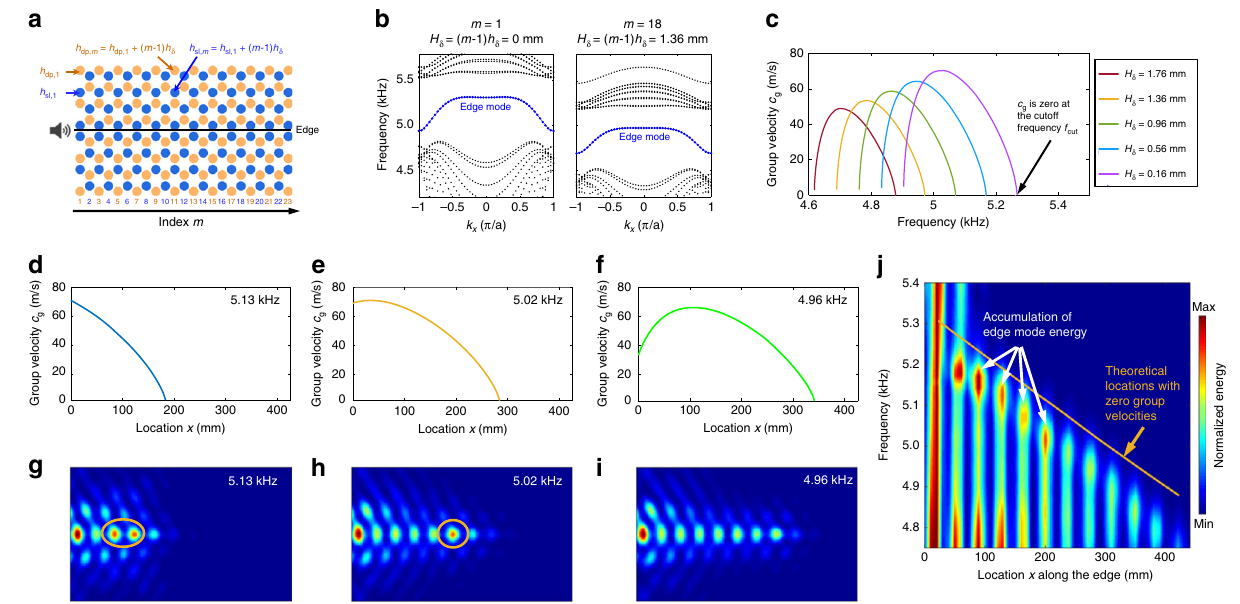
Fig. 5 Demonstrations of rainbow edge waves in chirped valley phononic crystals. a Con fi guration of chirped valley phononic crystals (PCs) for transporting edge modes of surface acoustic waves (SAWs) along a straight interface. The blue and brown circles in the m th column represent shallow and deep cavities with depths of h sl ,m and h dp ,m . The cavity depths gradually increase with the increase of column index m following the relations h sl ,m = h sl,1 + ( m − 1) h δ and h dp ,m = h dp,1 + ( m − 1) h δ . The depths of the shallow and deep cavities in the fi rst column are h sl,1 = 8.58 mm and h dp,1 = 10.58 mm, respectively. The step size h δ is 0.08 mm. b Wavenumber-frequency dispersion curves of edge modes for type A – B supercells with H δ = 0 mm in the 1st column (left) and H δ = 1.36 mm in the 18th column (right). The depth change H δ equals to ( m − 1) h δ . c Dispersion curves of edge mode group velocities c g for type A – B supercells with different H δ from 0.16 to 1.76 mm. The group velocity is zero at the cutoff frequency f cut . d – f Theoretical group velocities versus location x along the interface of the chirped valley PCs at frequencies of 5.13, 5.02, and 4.96 kHz. g – i Experimental energy fi elds of edge waves in the chirped valley PCs at frequencies of 5.13, 5.02, and 4.96 kHz. The energy fi elds show that SAWs at different frequencies stop propagating forward at different locations in the interface. Accumulation of edge mode energy in the low group velocity region can be observed in g , h . j Two-dimensional distribution of the edge mode energy with respect to location x along the interface and frequency. The locations where edge waves stop propagating forward agree well with the theoretically predicted locations with zero group